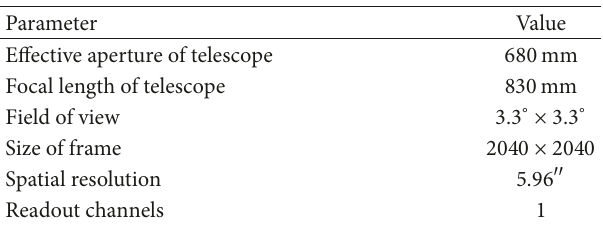
Table 1: Parameters of the